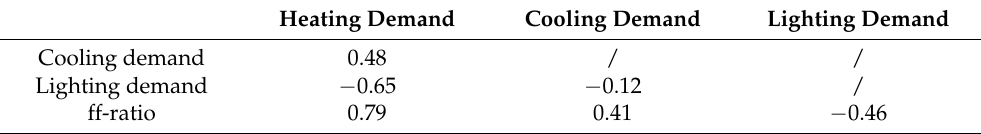
Table 5. Correlation coefficients between energy demands and ff-ratio for the